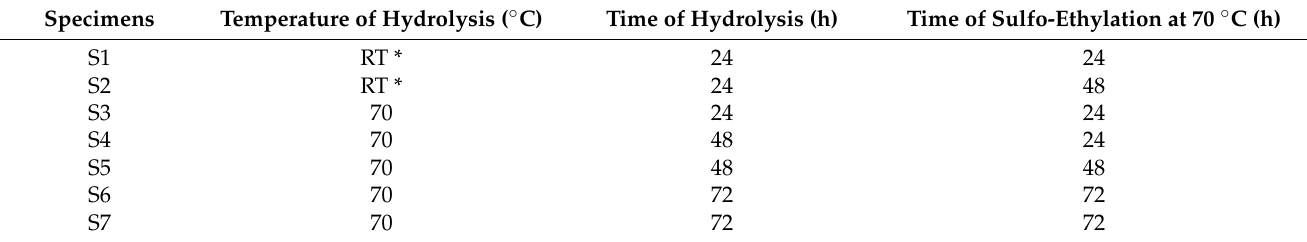
Table 1. Library of synthesized materials at different temperature and times of hydrolysis and sulfo-ethylation. Specimens Temperature of Hydrolysis ( ◦